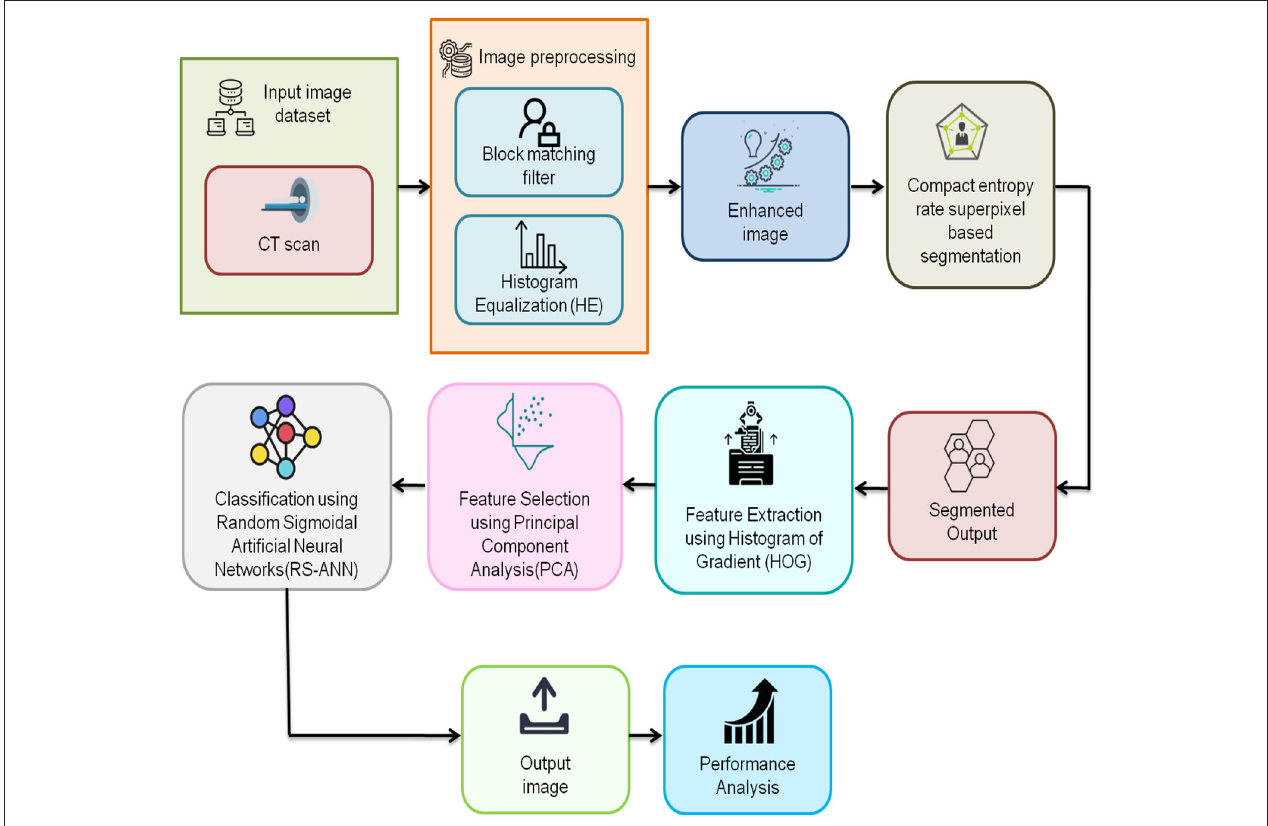
FIGURE 2 | Schematic representation of the suggested methodology.